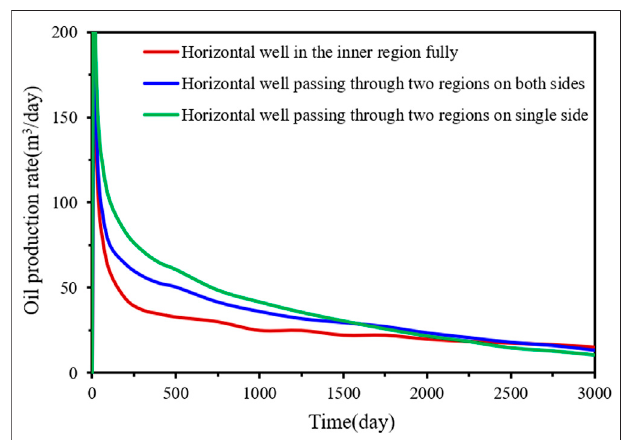
FIGURE 3 | Production rate decline curves for the above three